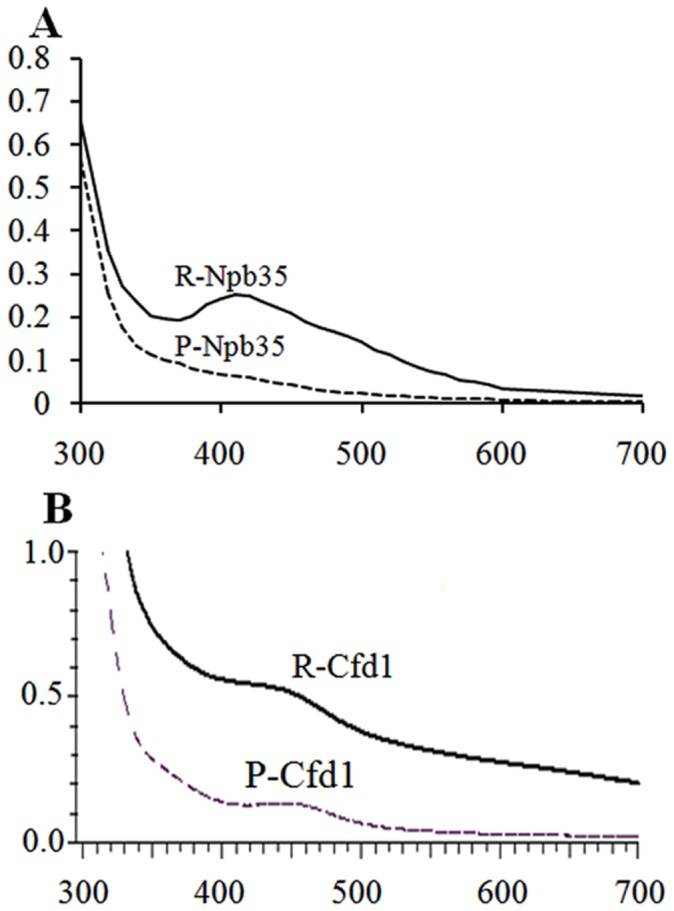
UV-Visible spectra of purified and reconstituted rNbp35 and rCfd1 proteins.A) As purified rNbp-35 and rNbp35 after chemical reconstitution was scanned in the UV-Vis range to detect Fe-S cluster. Solid and dashed lines represent reconstituted Nbp35 and purified Nbp35, respectively. B) UV-visible spectra of purified rCfd1 and reconstituted rCfd1protein in which, solid and dashed lines represent reconstituted rCfd1 and purified rCfd1, respectively.